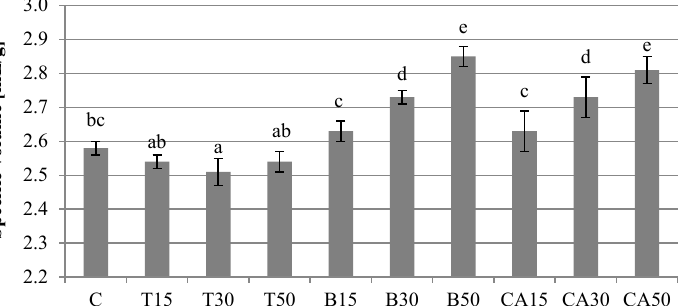
Figure 1. The specific volume of the analyzed breads. Bars represent means ± standard deviation, ( n = 9, for each bread type). The values marked with different letters are significantly different ( p < 0.05).